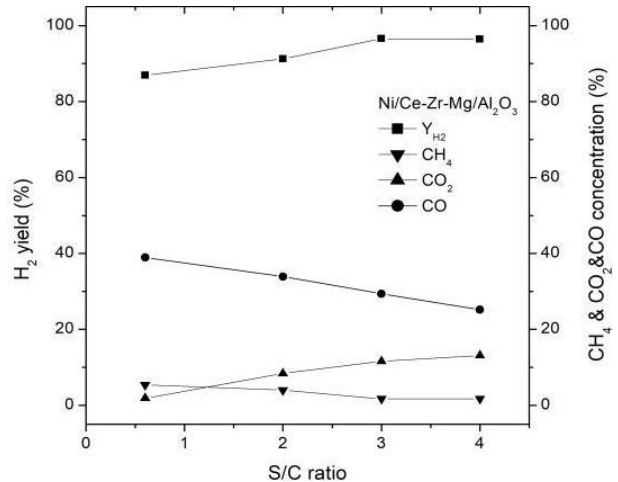
Figure 9. Hydrogen yield according to the S/C ratio . (temp.= 850 °C, GHSV=10,000h -1 ).